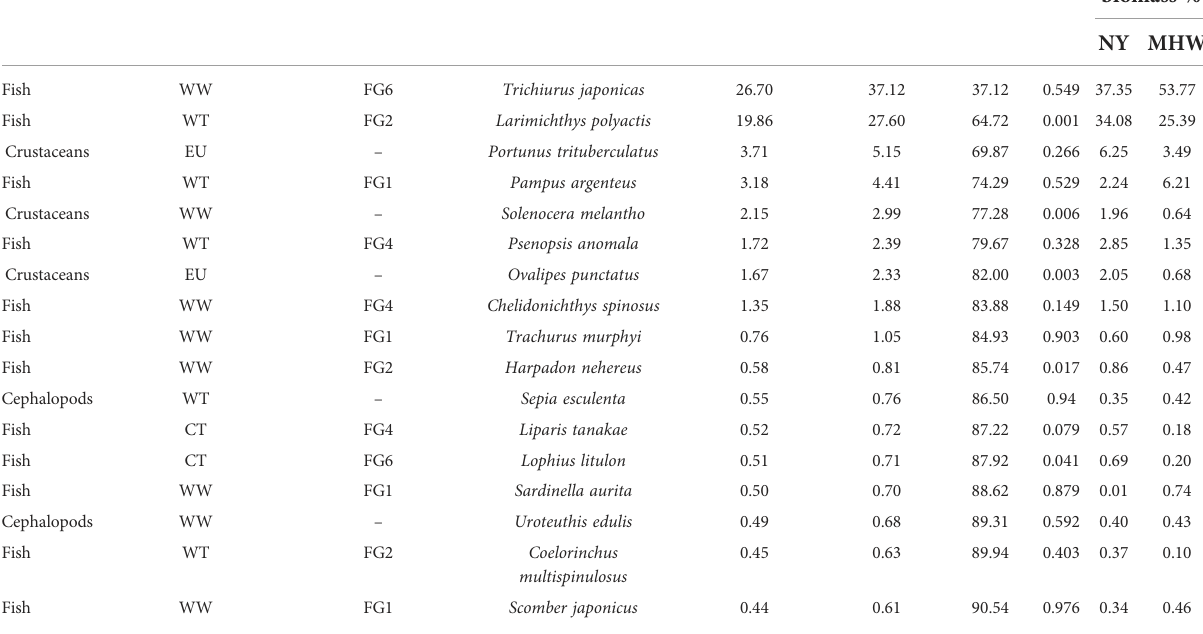
Table 3 Similarity of percentage analysis of community dissimilarity (Bray – Curtis) between NY and MHW samples. Taxon Thermal condition Fish Feeding FG.